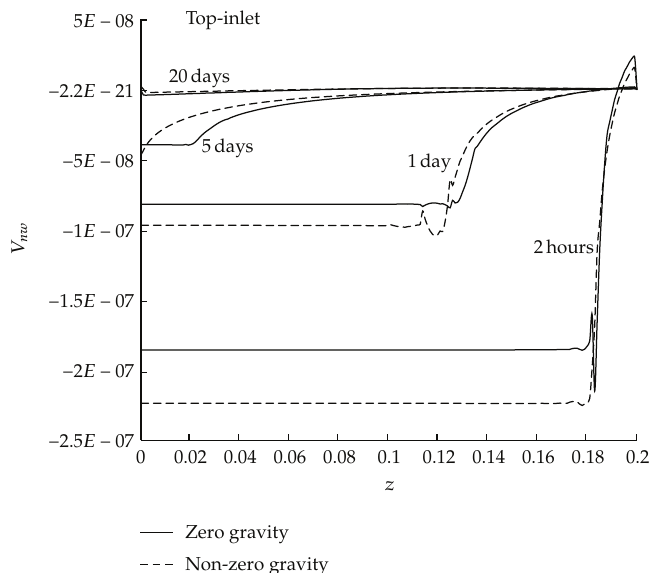
Figure 13: Comparison between considering and neglecting gravity e ff ect on oil z -velocity for the top-inlet case, at x (cid:8) 0 .